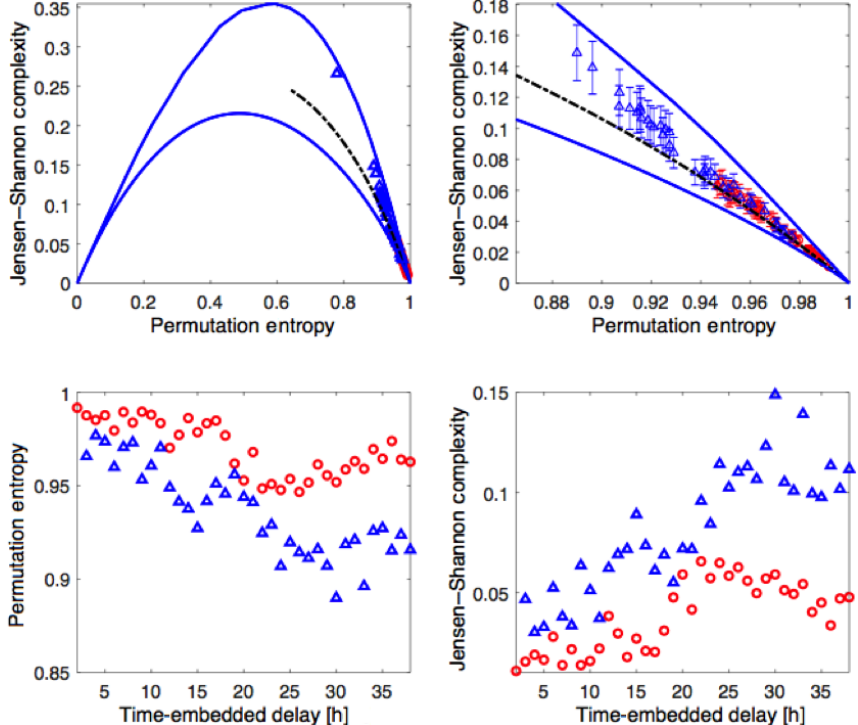
Figure 5. Jensen–Shannon complexity and permutation entropy, AL (red) and am (blue) for 500 points with no gaps sampled at 1h interval, embedding dimension d = 4, and embedding delays ranging between 2 and